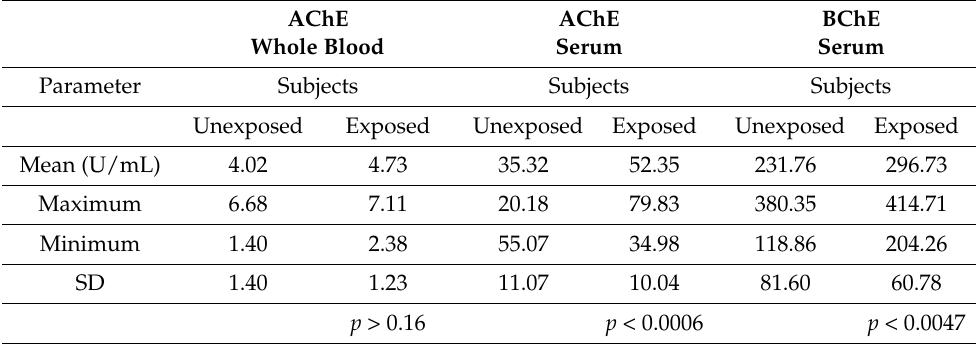
Table 3. Comparison of cholinesterases activities in study population.